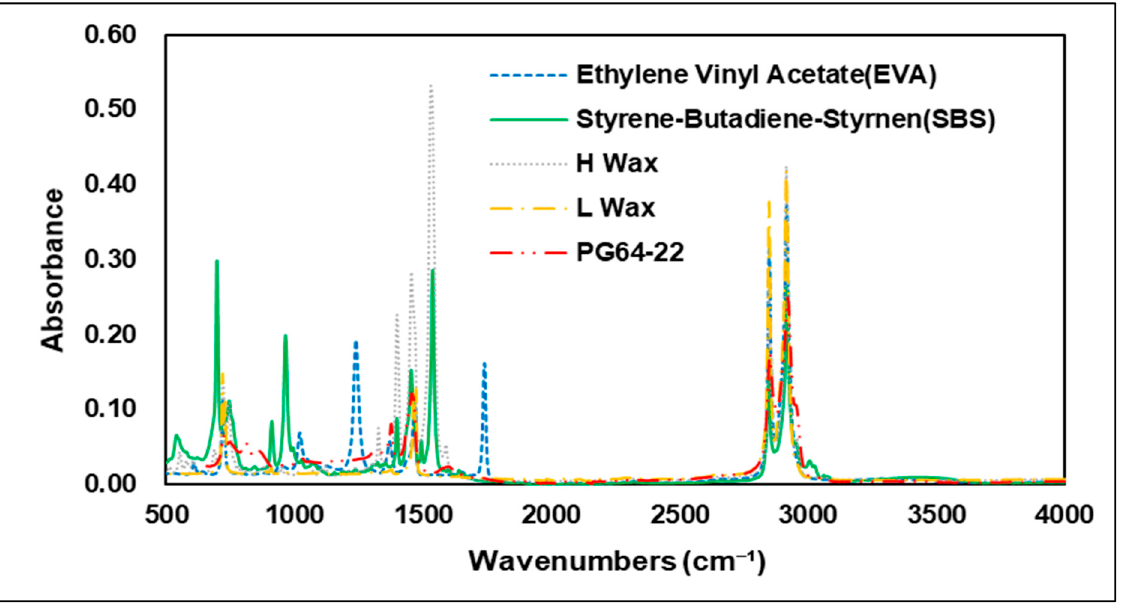
Figure 4. FTIR spectrum of asphalt binder additives.